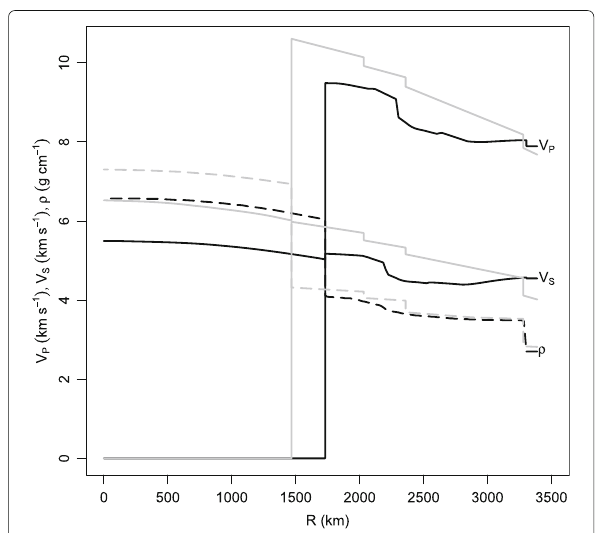
Fig. 6 Radial wavespeed and density profiles of two Mars internal structure models, Rivoldini et al. (2011) (R11DW black) and Sohl and Spohn (1997) (SS97a gray). The most pronounced difference between them is their core size. Other important seismological details are that R11DW’s core wavespeed is lower than V S at the base of the mantle, whereas SS97a’s is slightly